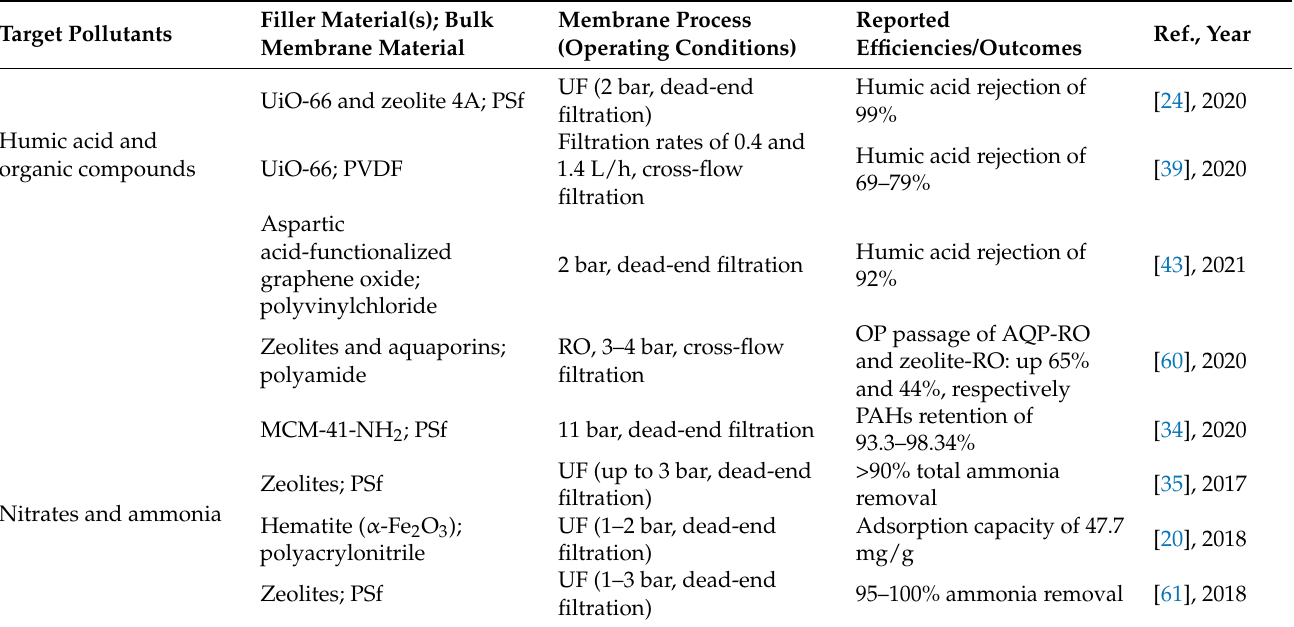
Table 3. A summary of emerging materials used to fabricate MMMs for pollutant removal. The pollutants are categorized into two themes: (1) humic acid/organic compounds and (2)